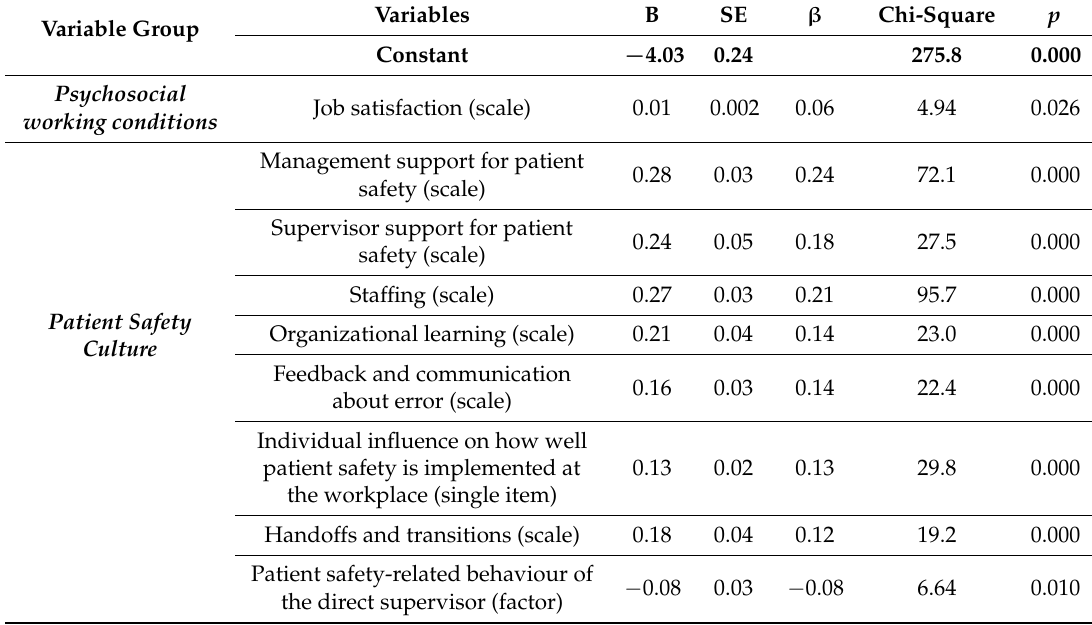
Table 7. Patient Safety Culture model—stepwise linear regression analysis adjusted for cluster effects.